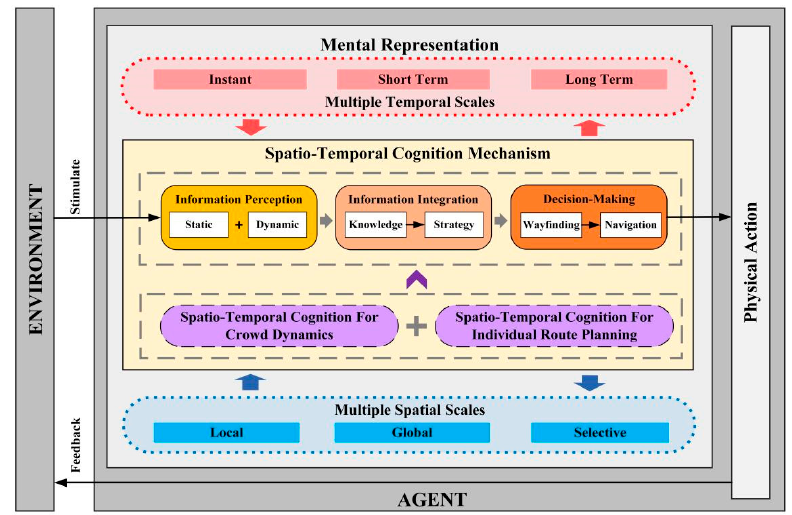
Figure 1. Overview of the spatio-temporal cognitive framework for individual route choice.